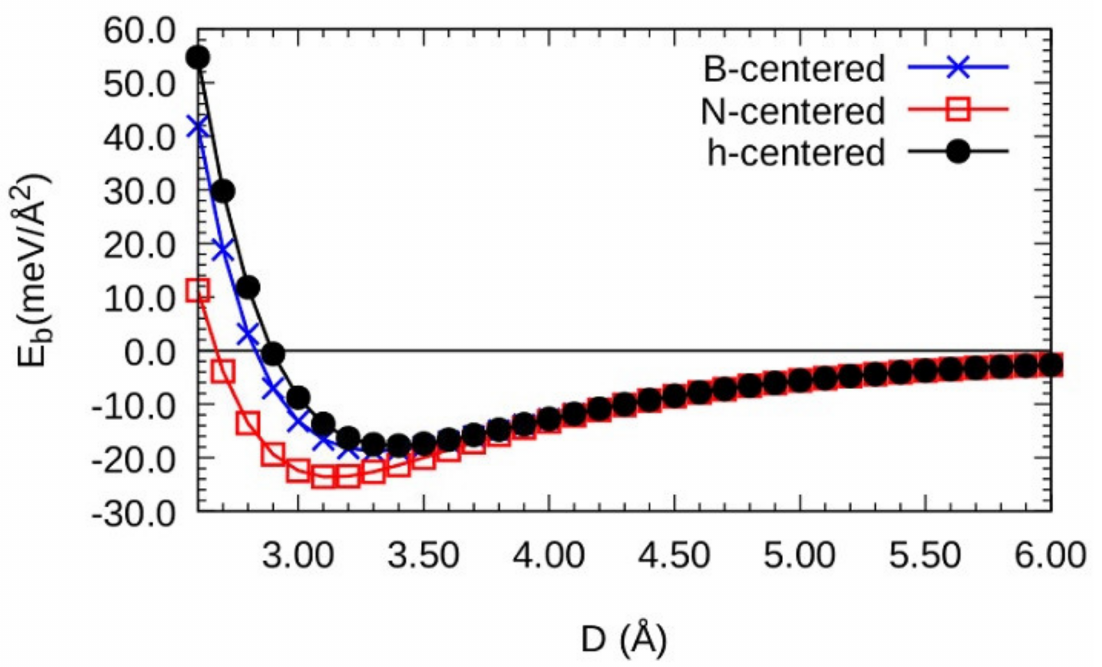
Figure 2. Bond energy ( E b ) vs. interfacial distance (D) for the vertical stacking h-BN/graphene heterobilayers; B-centered stacking (blue line and crosses), N-centered stacking (red line and squares), and h-centered stacking (black line and